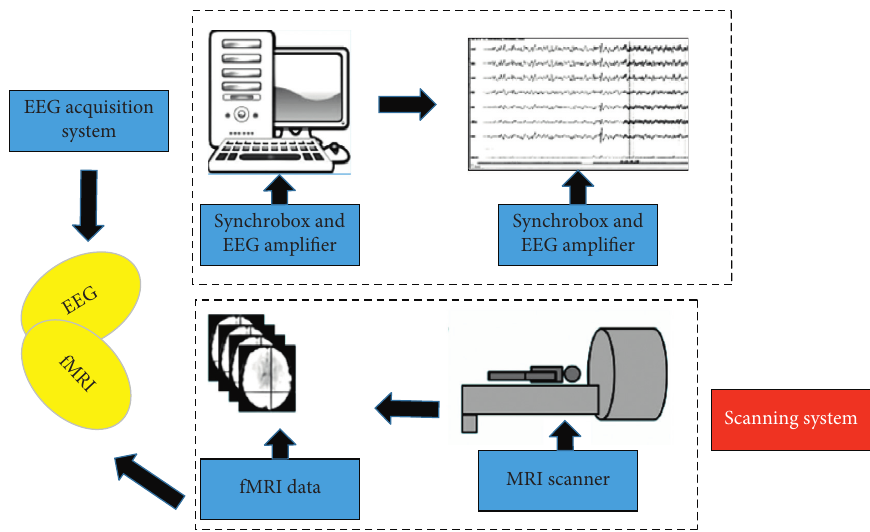
Figure 1: Data collection of EEG and fMRI neuroimaging